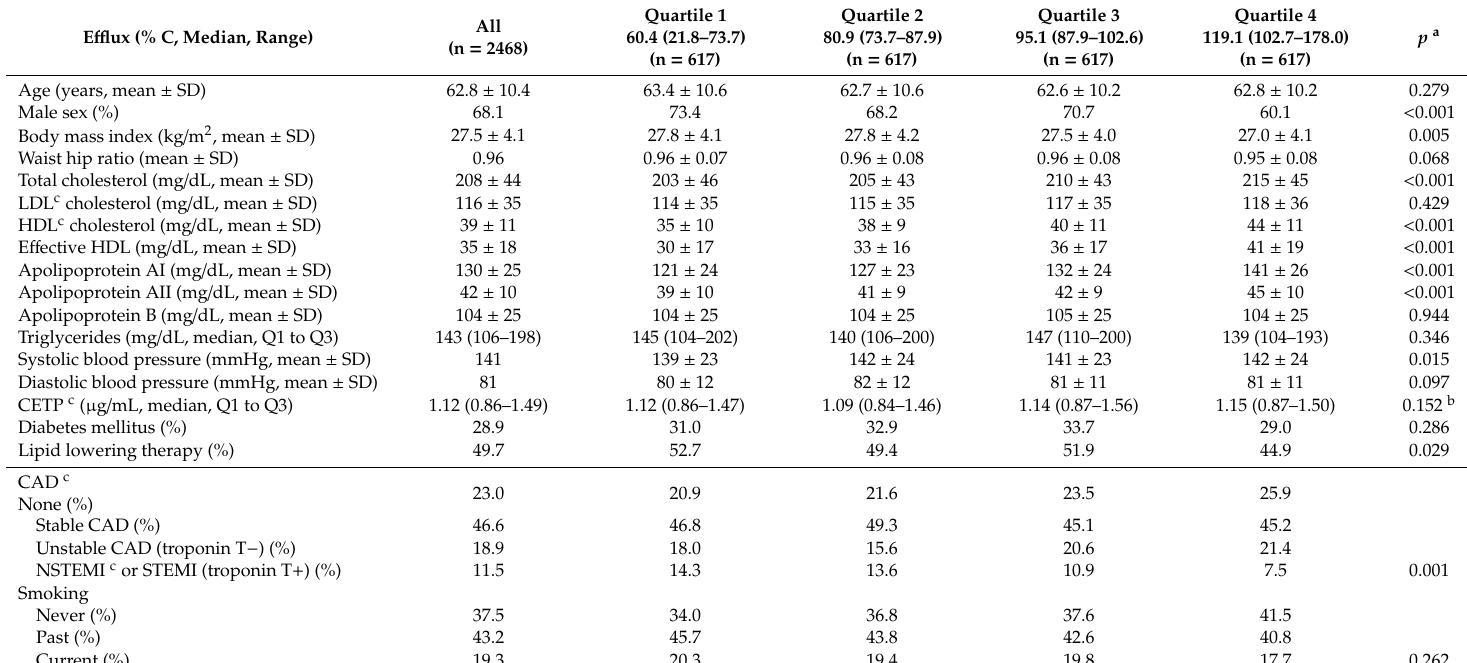
Table 1. Clinical and biochemical characteristics of study participants at baseline according to cholesterol e ffl ux capacity